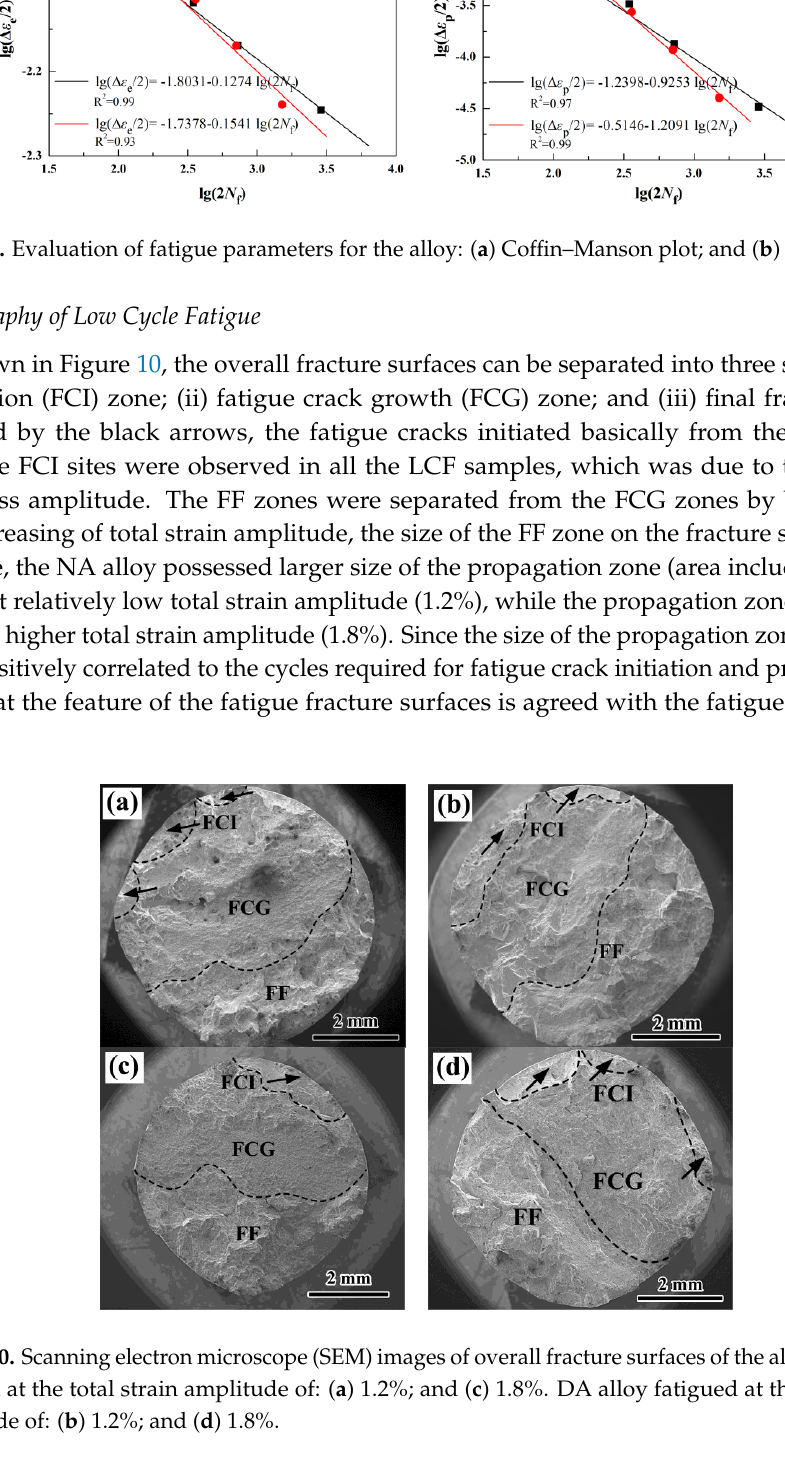
Figure 9. Evaluation of fatigue parameters for the alloy: ( a ) Coffin–Manson plot; and ( b ) Basquin plot.